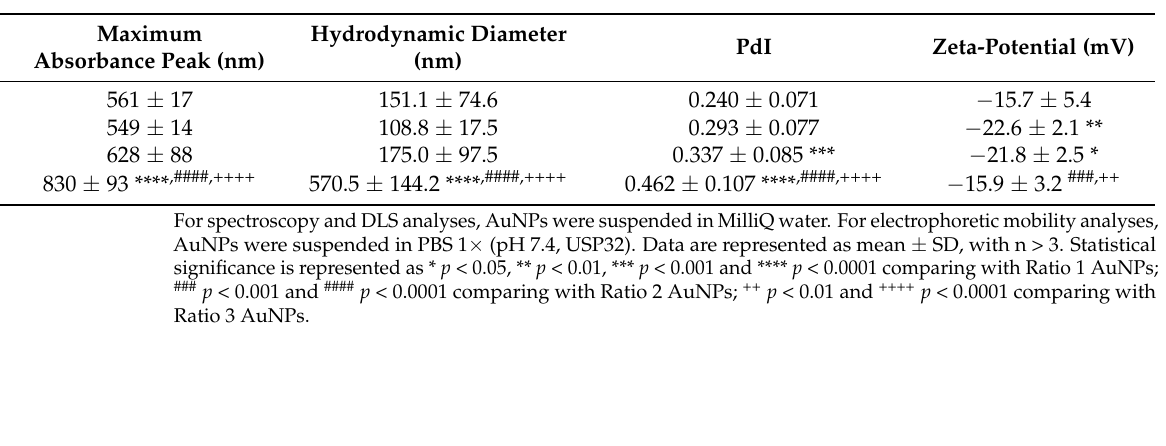
Table 2. AuNPs physicochemical characterization.